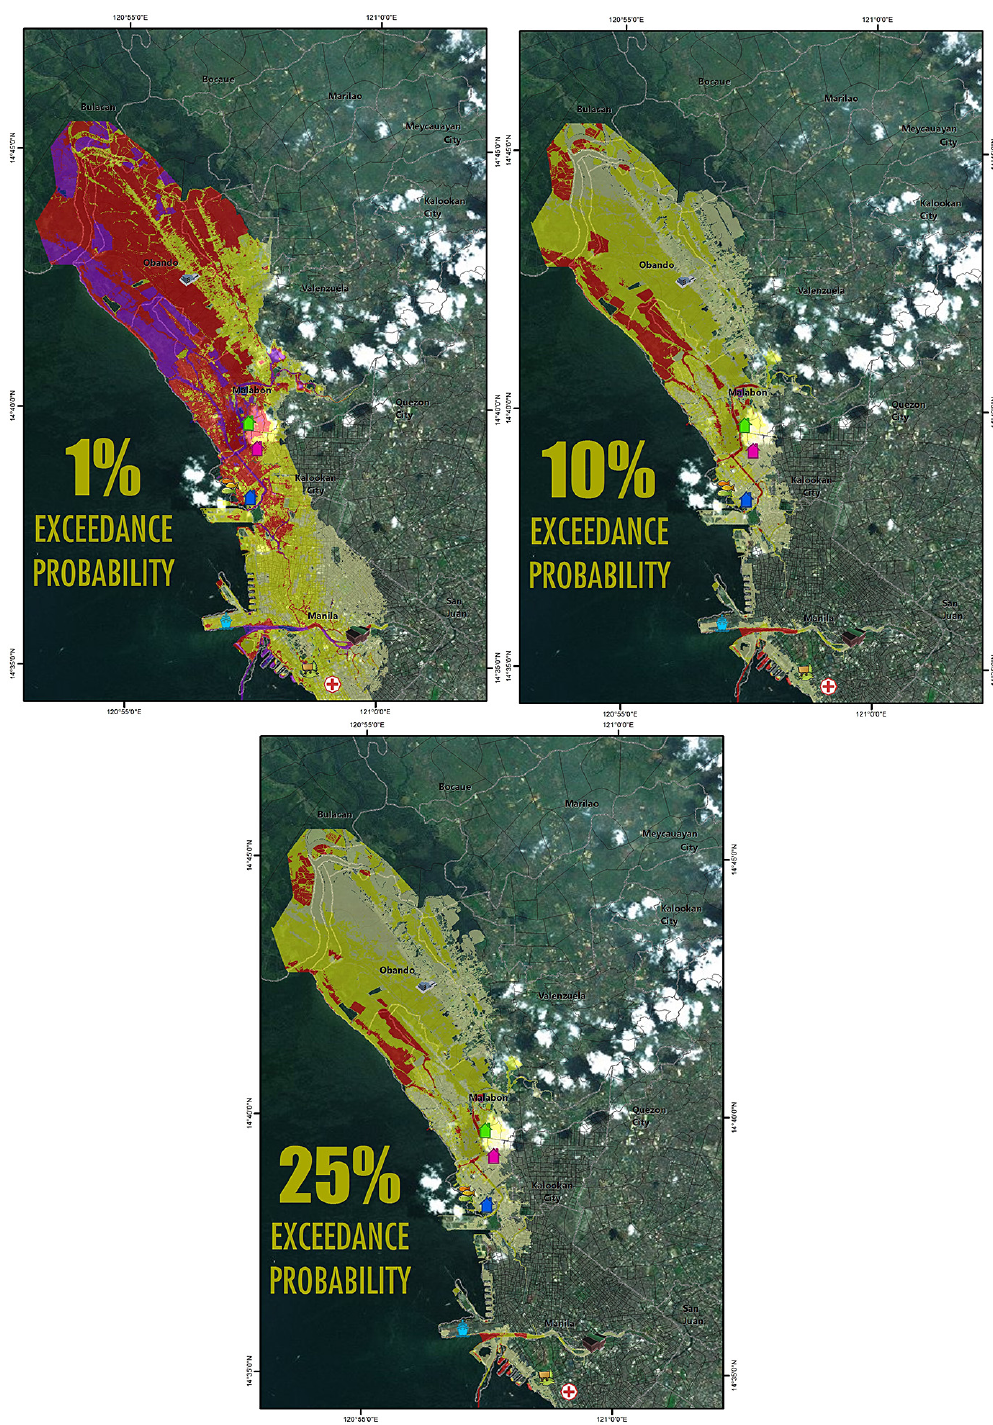
Figure 9. Storm surge inundation maps for PSWS 1 (please refer to Fig. 12 for the